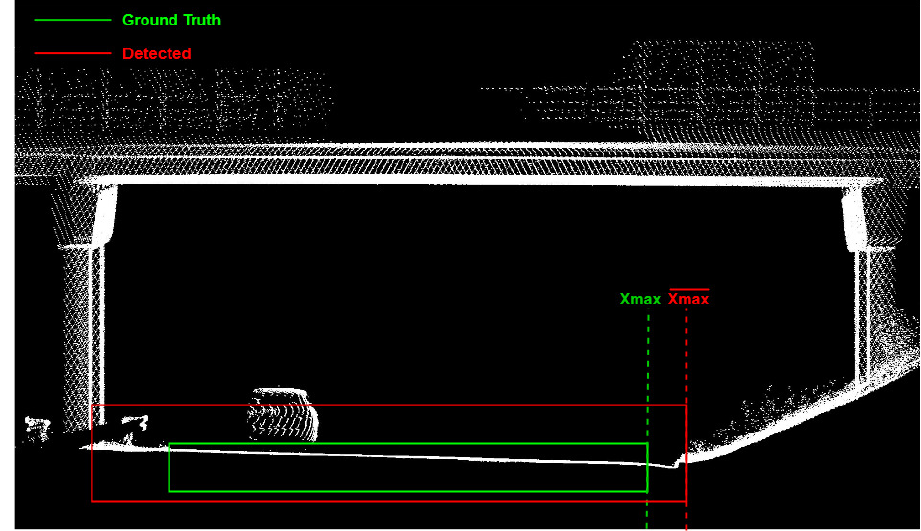
Figure 6. Example of road cross section with ground truth and detected road bounding boxes.